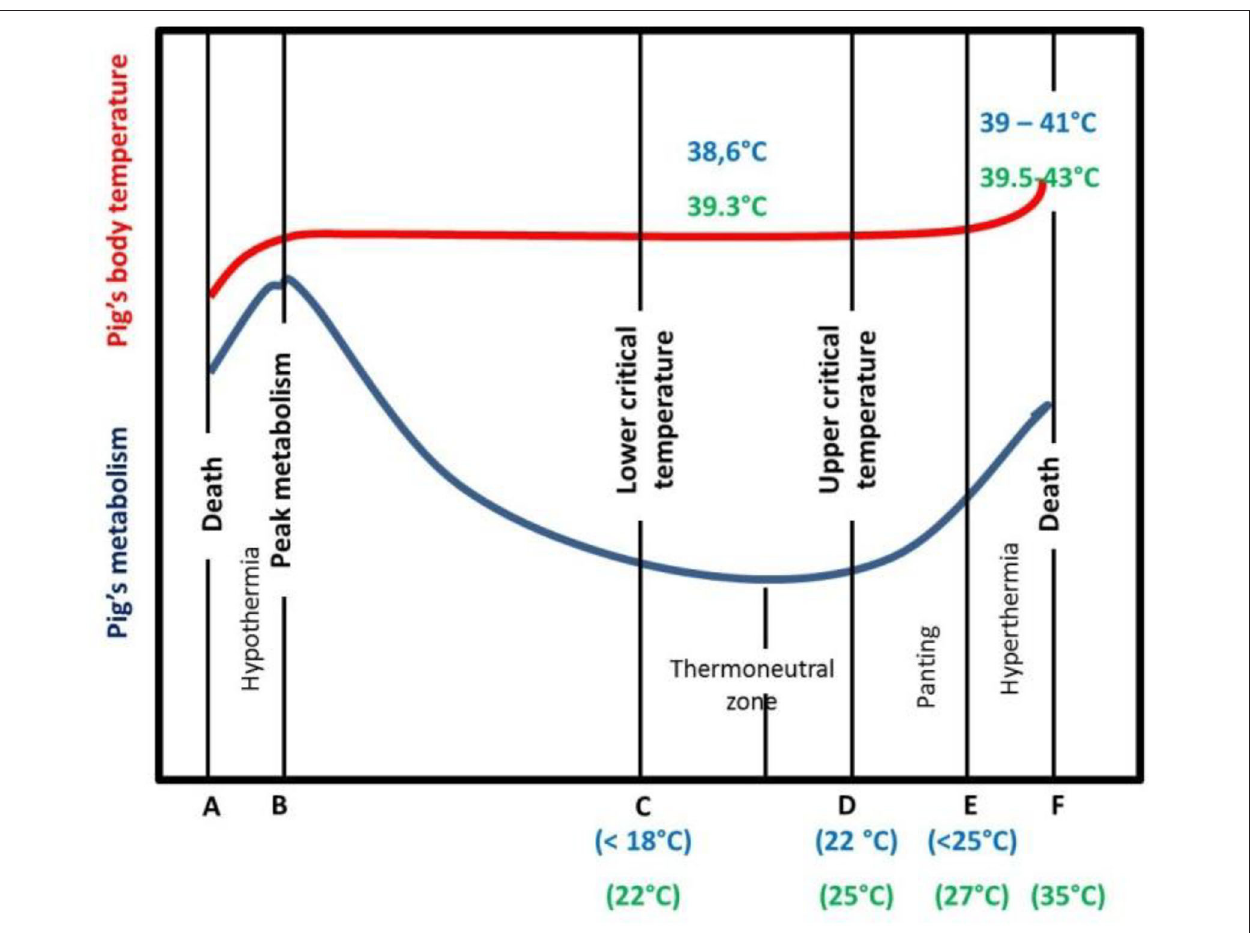
FIGURE 1 | Diagrammatic presentation of the effect of ambient temperature on lactating sow (indicative values in blue) and growing pig (indicative values in green) metabolism and body temperature [adapted from (32)]. The lower critical temperature is the ambient temperature below which pigs must increase heat production to maintain heat balance. The upper critical temperature is the ambient temperature above which pigs must increase heat loss rate to achieve heat